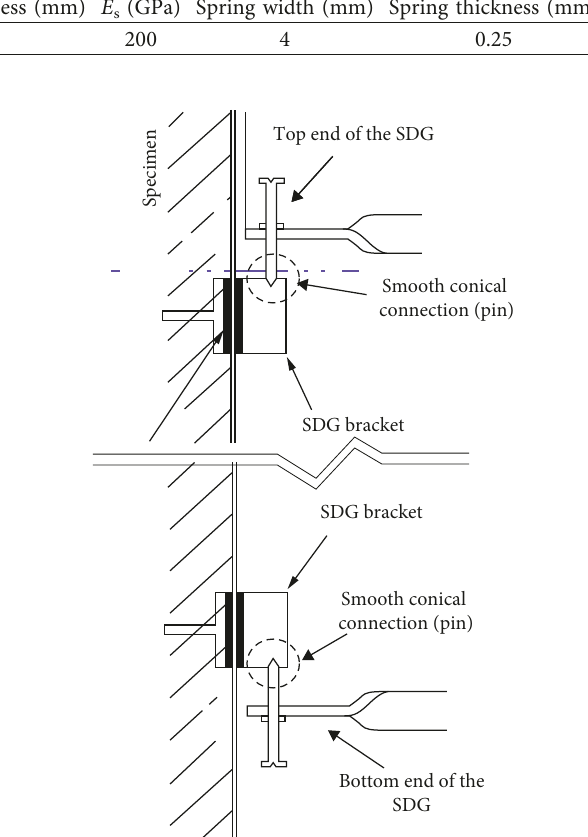
Figure 7: Details showing connection of SDG to